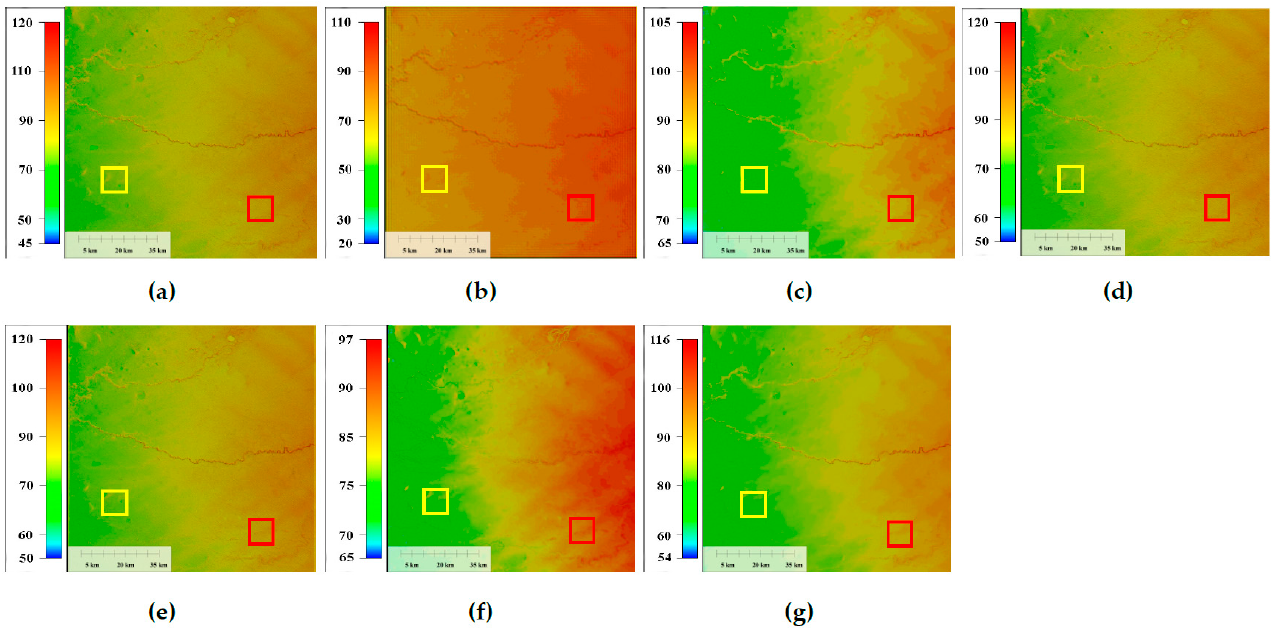
for visual evaluation. Figure 13 show partial enlargements of the corresponding data.